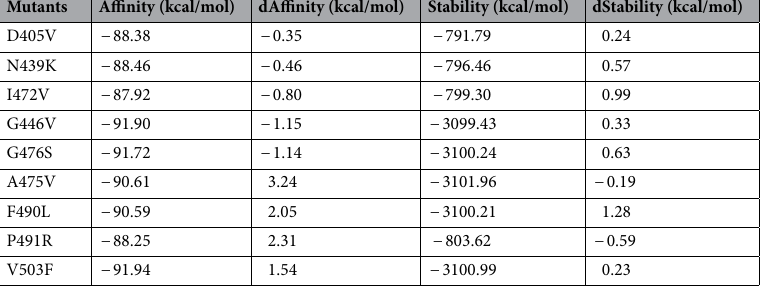
Table 3. The affinity of the variants of SARS-CoV-2 spike RBD bound to human ACE2, red marks the enhanced ones while black represents the decreased ones.